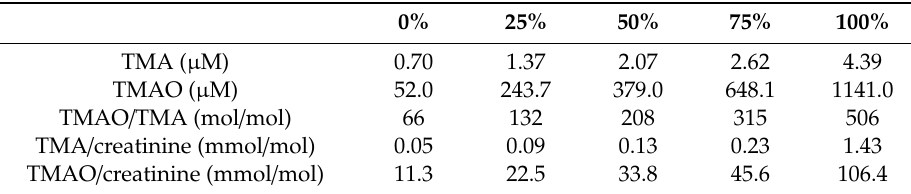
Table 3. Quantile distribution of urinary TMA and